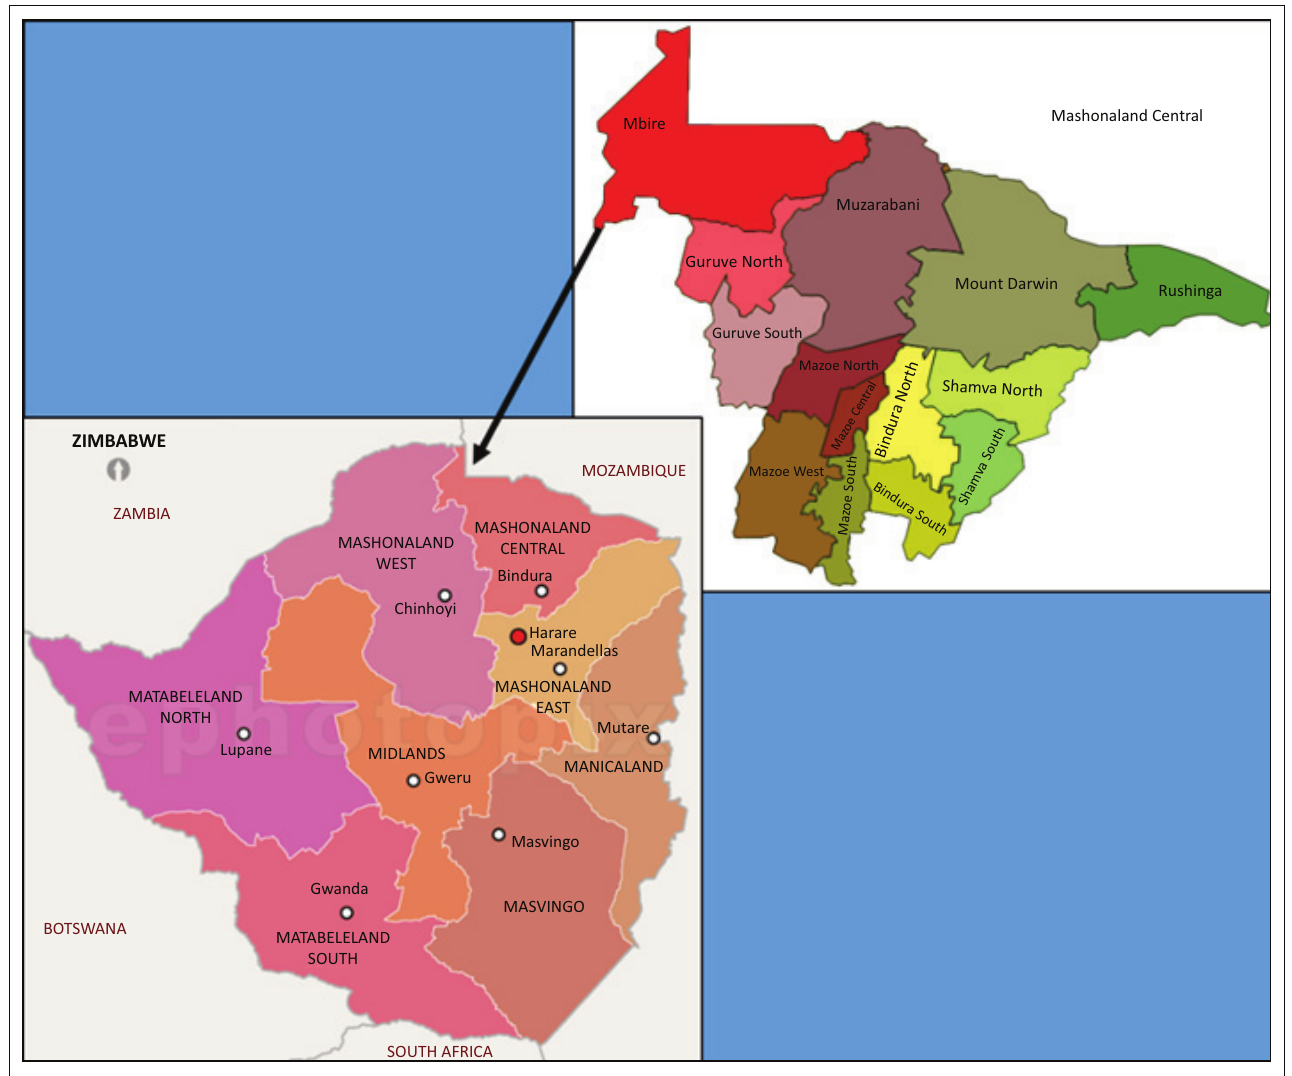
FIGURE 1: Map indicating the location of the Mbire